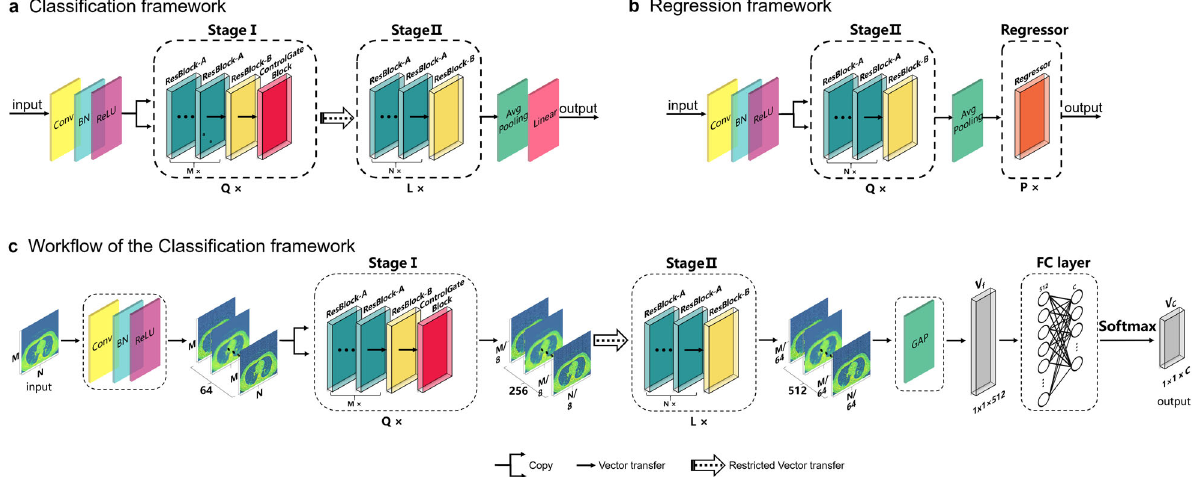
Fig. 3 CNN-based frameworks. a The classi fi cation framework for the identi fi cation of COVID-19. b The regression framework for the correlation analysis between the lesion areas and the clinical indicators. c is the work fl ow of the classi fi cation framework for the identi fi cation of